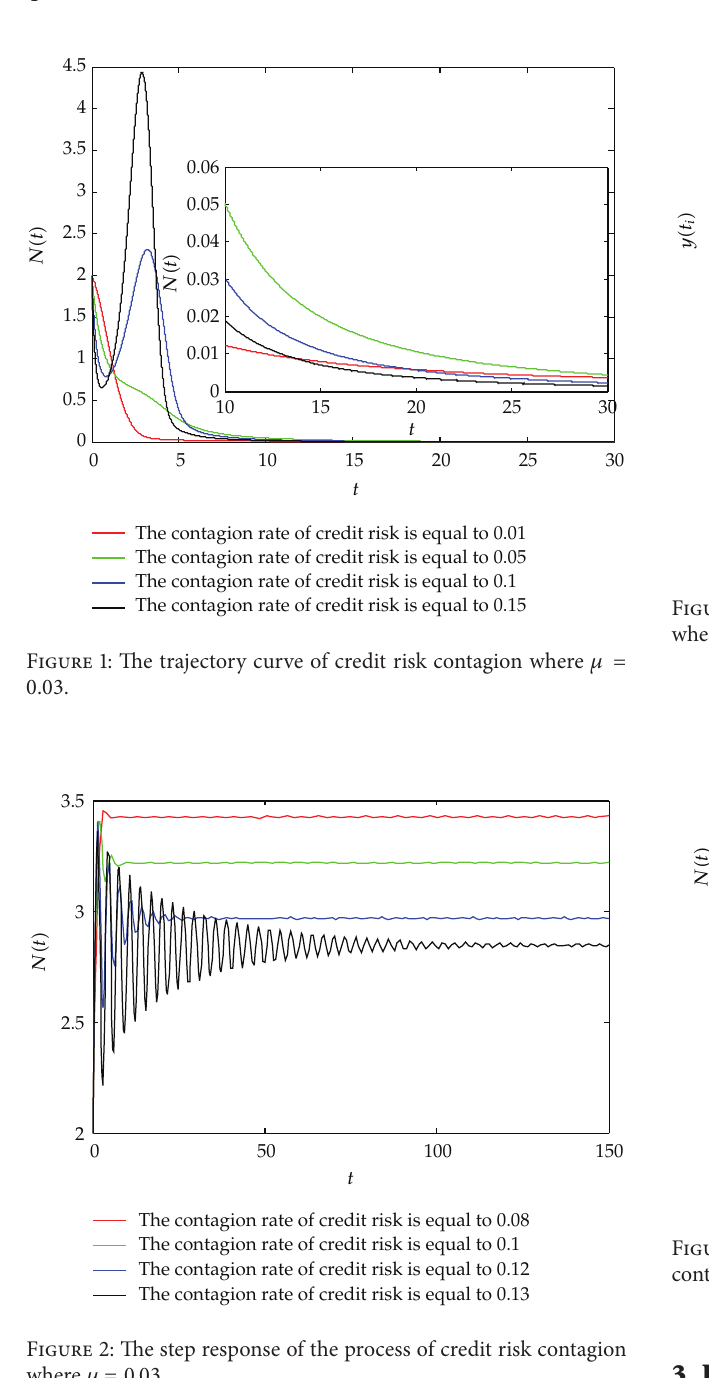
Figure 2: The step response of the process of credit risk contagion where 𝜇 = 0.03 .